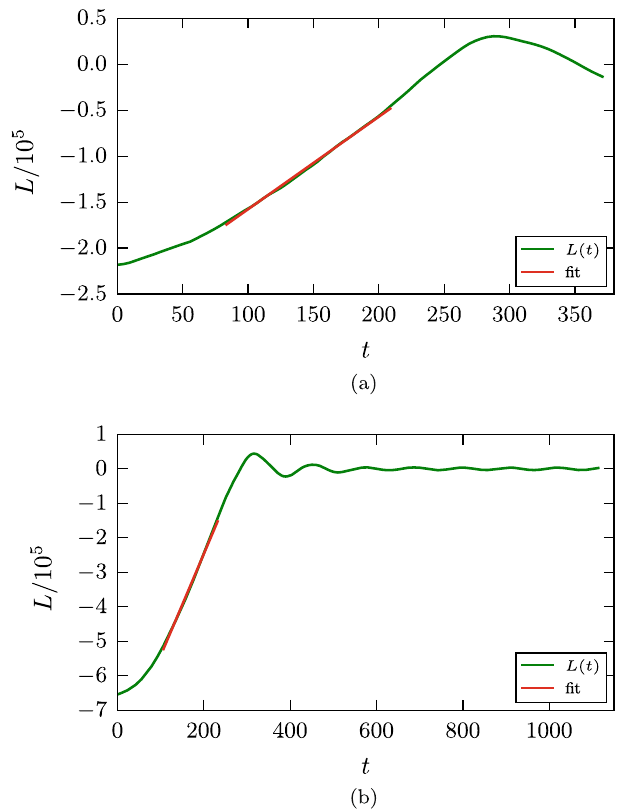
Figure 10. Twisting simulation: Temporal evolution of the angular momentum L for an initial angular velocity ω = 0.013 ( a ) and ω = 0.04 ( b ) for an intergrain attraction ǫ 12 = 0.75 .